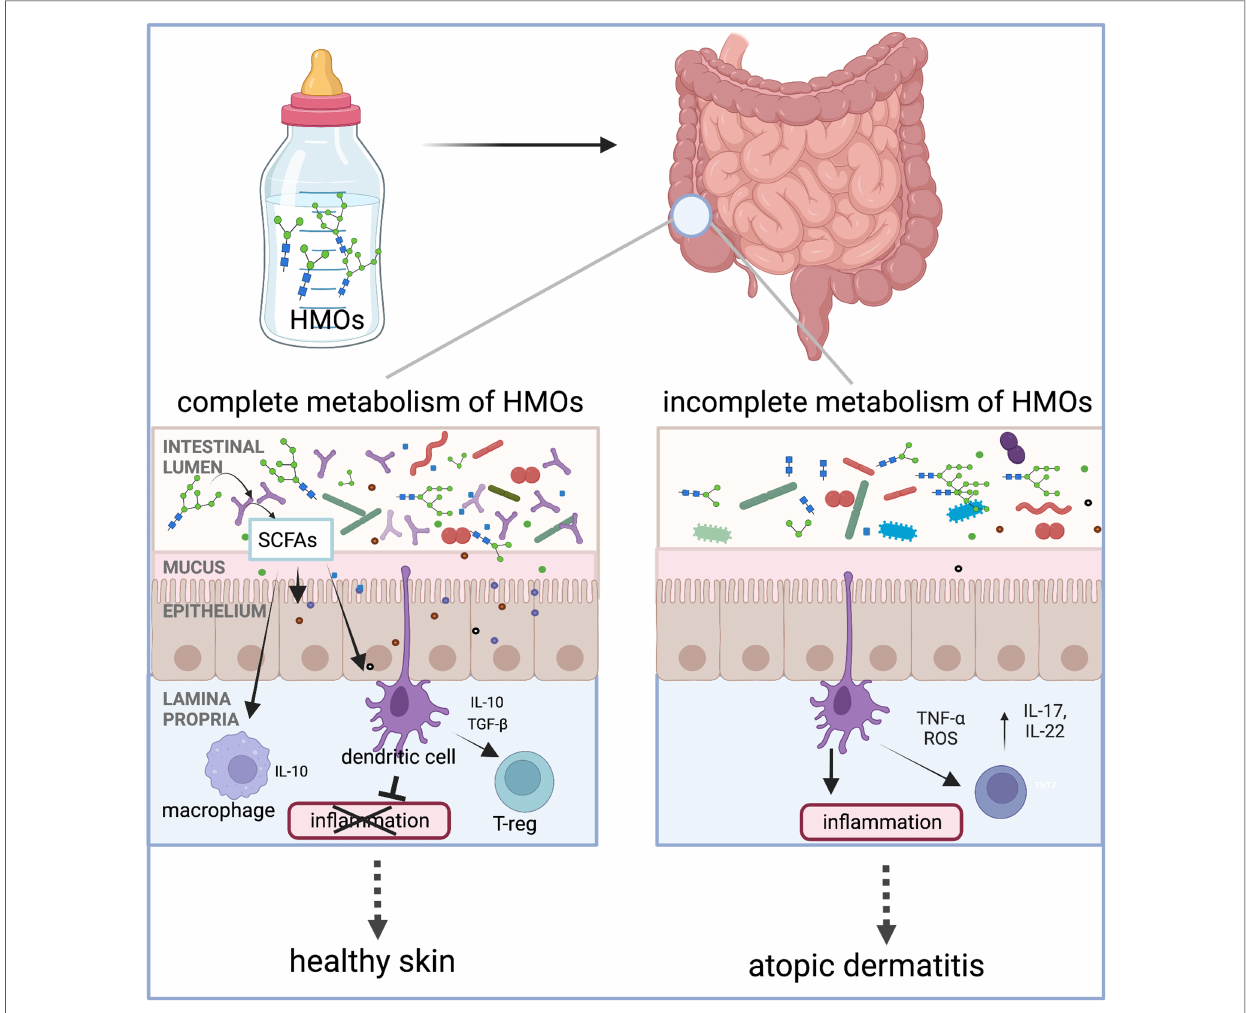
epithelial barrier to interact with immune cells in the lamina propria. Interaction between the dendritic cells and speci fi c HMO metabolites results in dendritic cells releasing interleukins, such as IL-10, which are involved in regulating in fl ammation. We hypothesize that infants with microorganisms